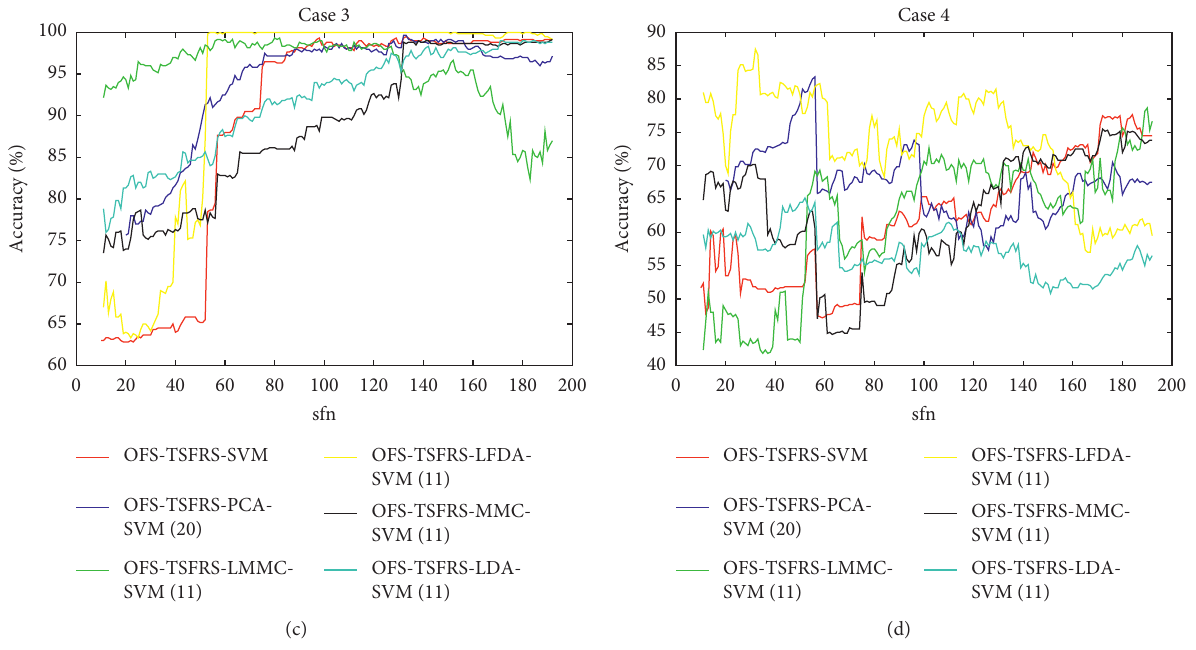
Figure 26: The diagnosis results of testing set of four cases with the use of TSFRS and different dimensionality reduction methods. The output dimension sizes of PCA, LDA, LFDA, MMC, and LMMC are 20, 11, 11, 11, and 11,